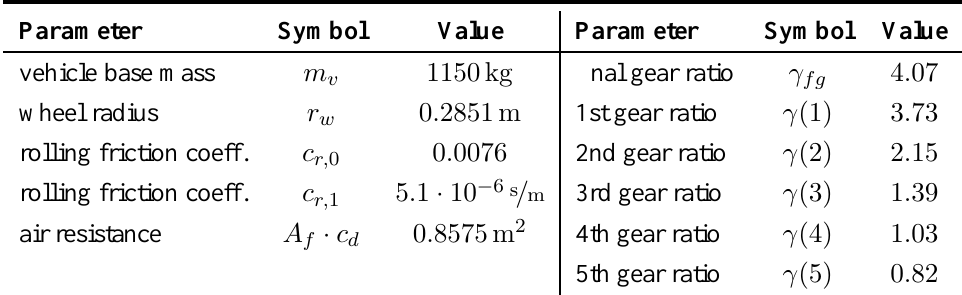
Table 2. Vehicle data: Nissan